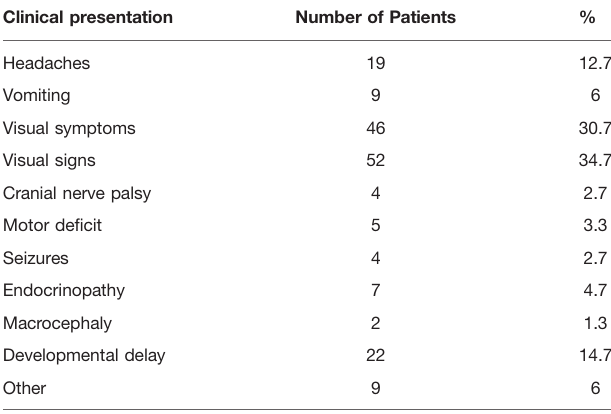
TABLE 1 | Clinical presentation of children leading to initial neuroimaging and diagnosis of OPG. Clinical presentation